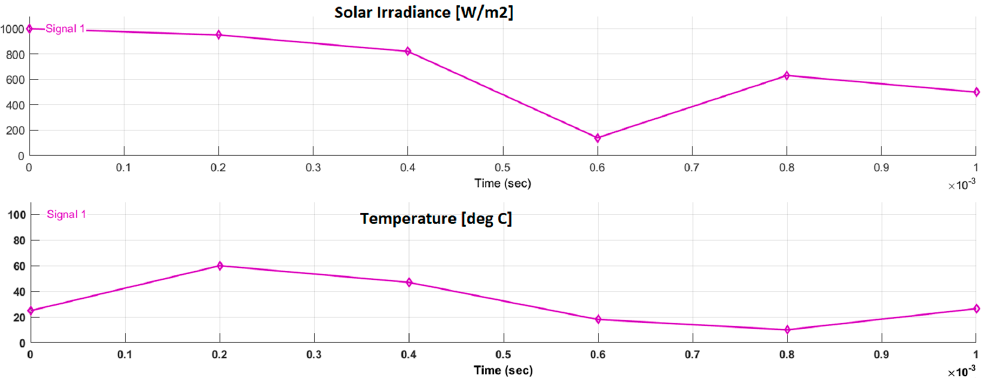
Figure 5. Solar Irradiance and Temperature variation.